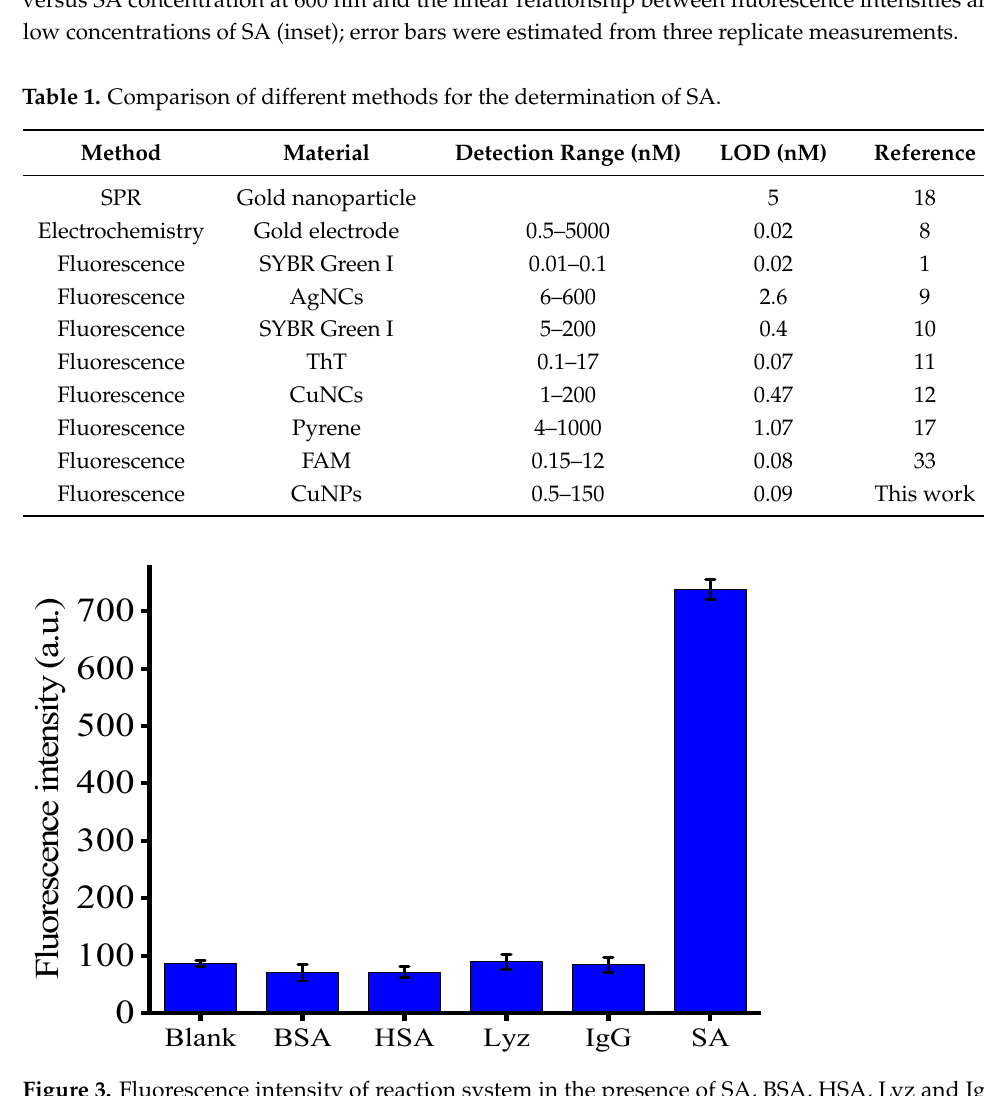
Figure 3. Fluorescence intensity of reaction system in the presence of SA, BSA, HSA, Lyz and IgG. Error bars were estimated from three replicated measurements.